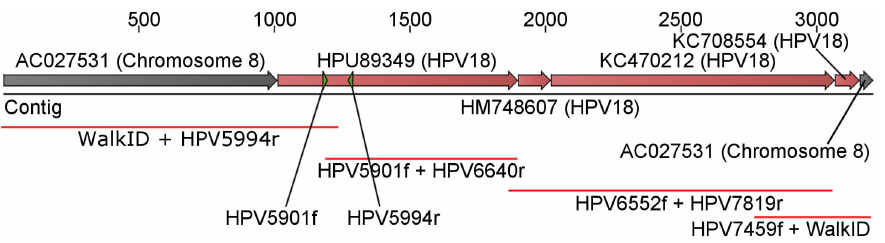
Figure 2. Alignment of RGW sequence and HPV specific sequencing from this study to published sequences on human chromosome 8 and HPV18 sequences. Positions of the primers used for detection of the HPV18 target sequence in the enrichment (HPV5901f and HPV5994r) are illustrated by small triangles in HPU89349.